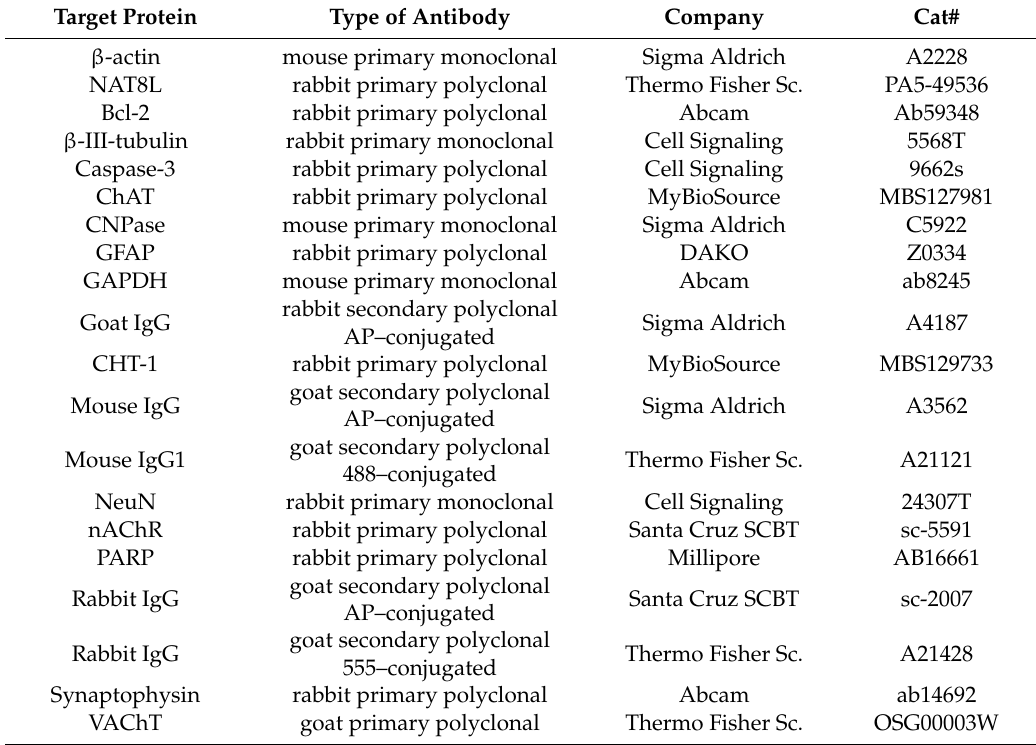
Table 5. A list of antibodies used in this